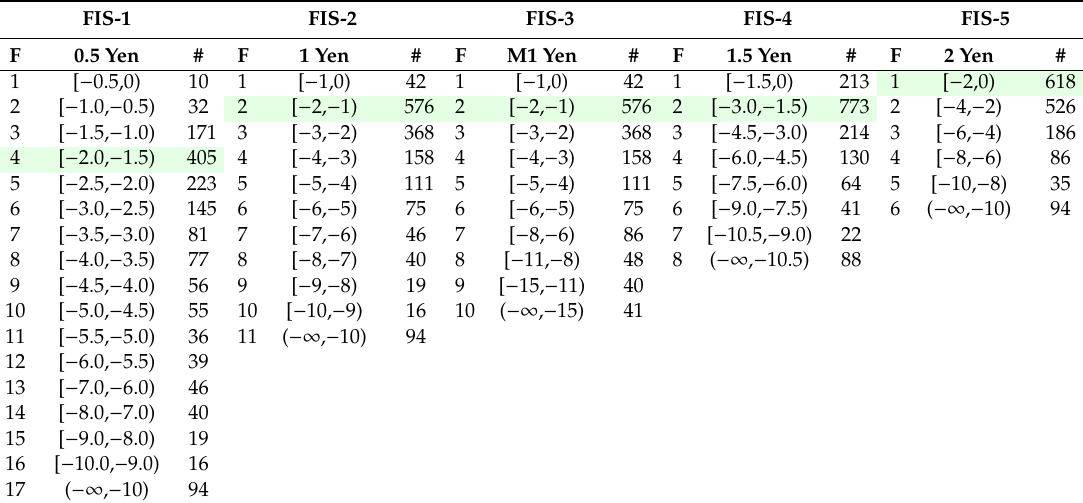
Table 5. Distribution of CBs under five fixed interval schemes (FISs) for 10 ς is